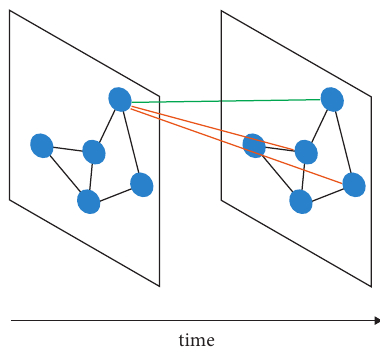
Figure 1: The structure of road network